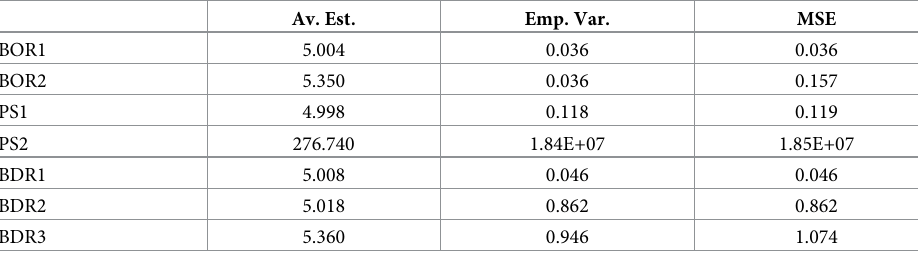
Table 1. Simulation results for posterior predictive distributions ( τ = 5.0). Av. Est. Emp.